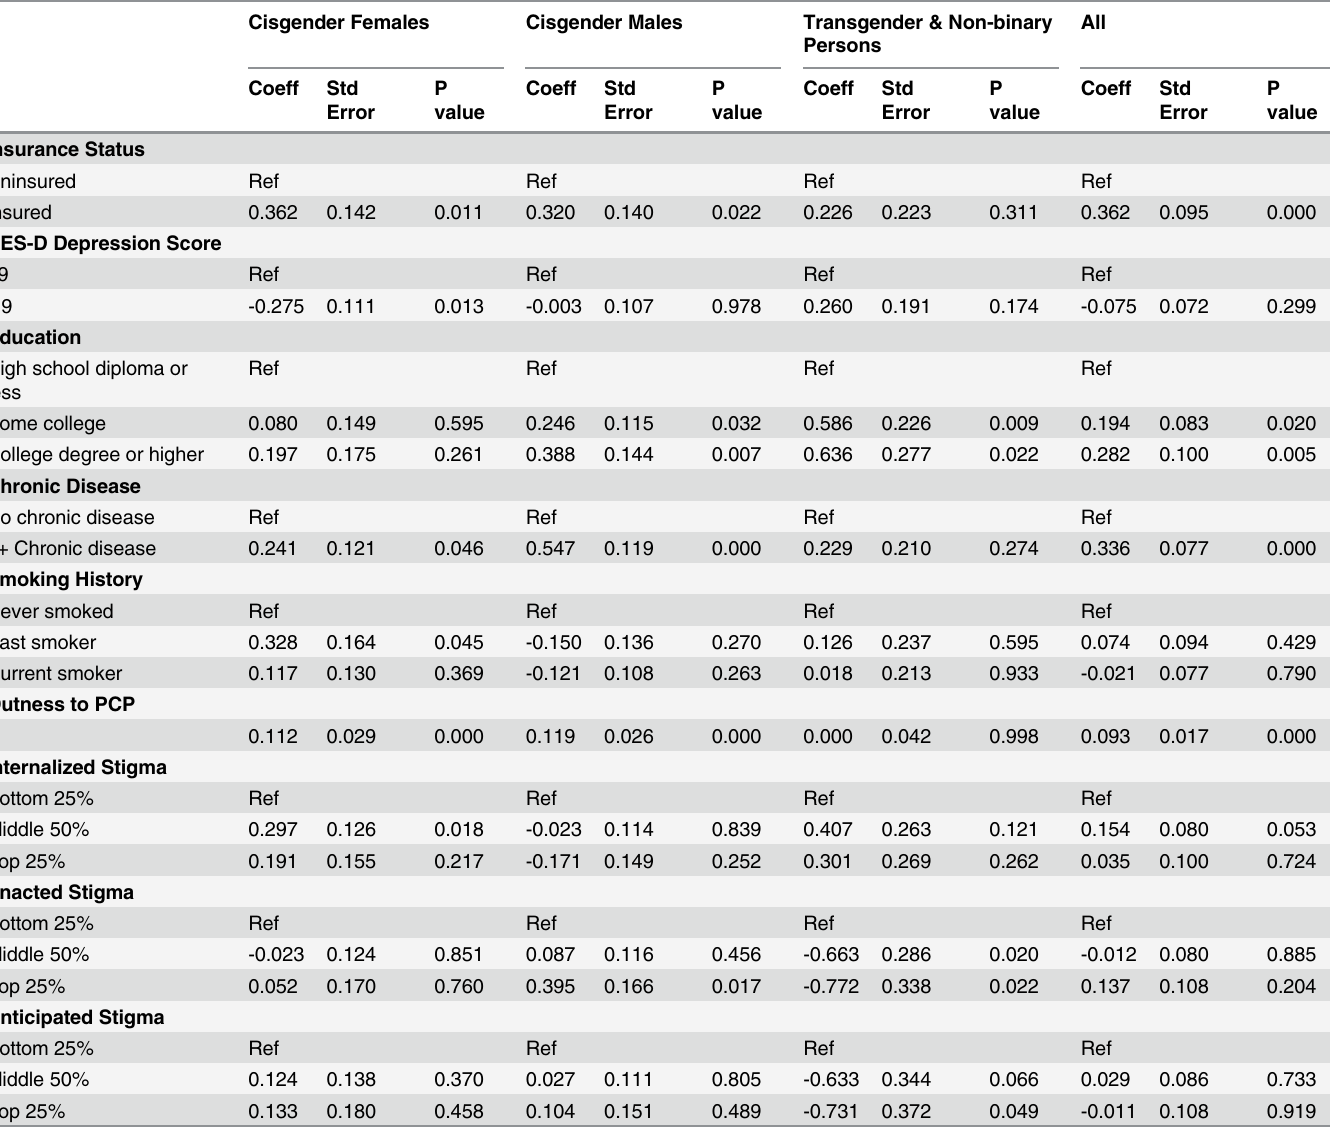
Table 5. Results of Linear Regression Model of factors associated with Health Care Utilization of an online sample of rural LGBT